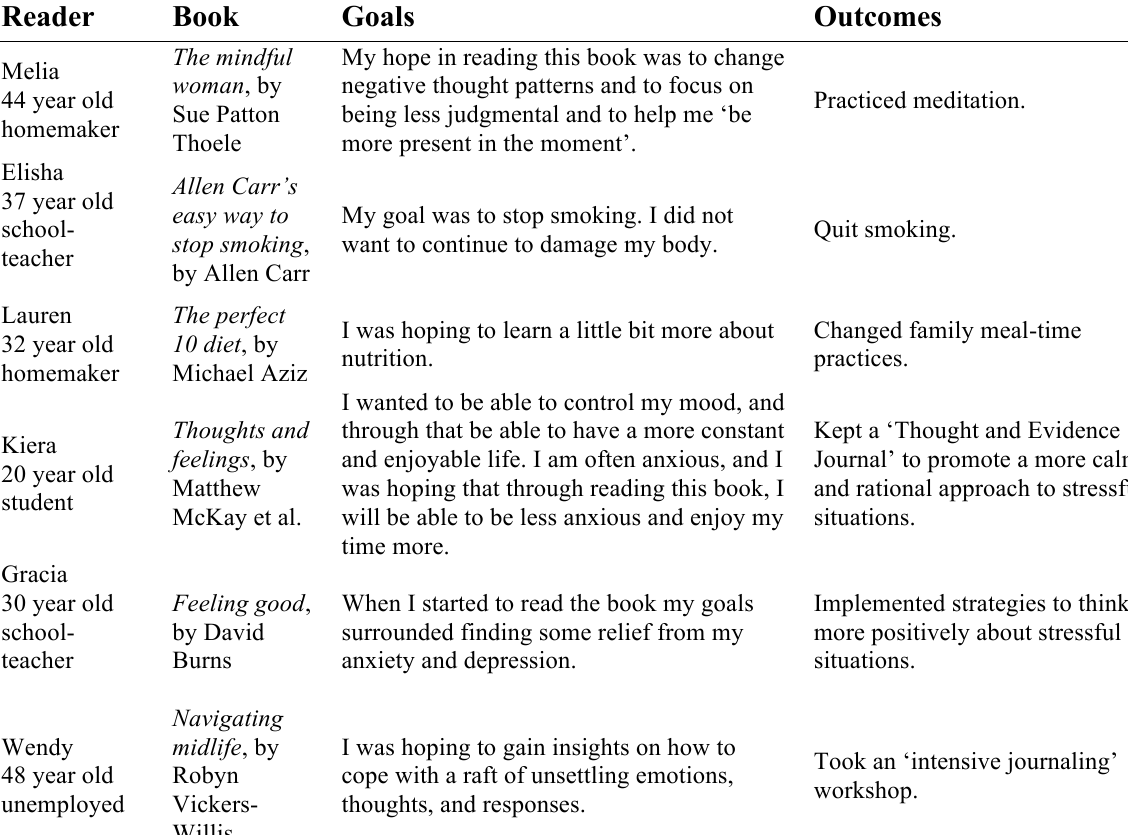
Table 6 : Female self-help reading and health Reader